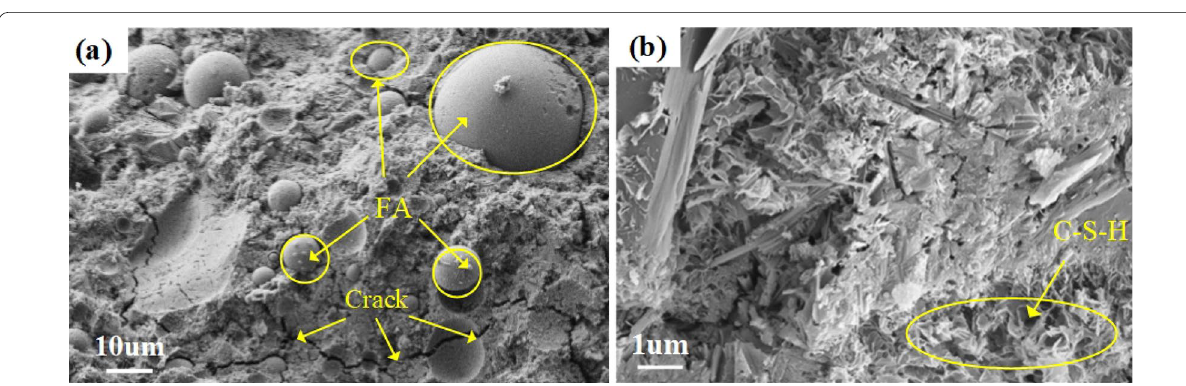
Fig. 6 SEM images of 20% fly ash cement paste: a Reaction degree of fly ash and b morphology of